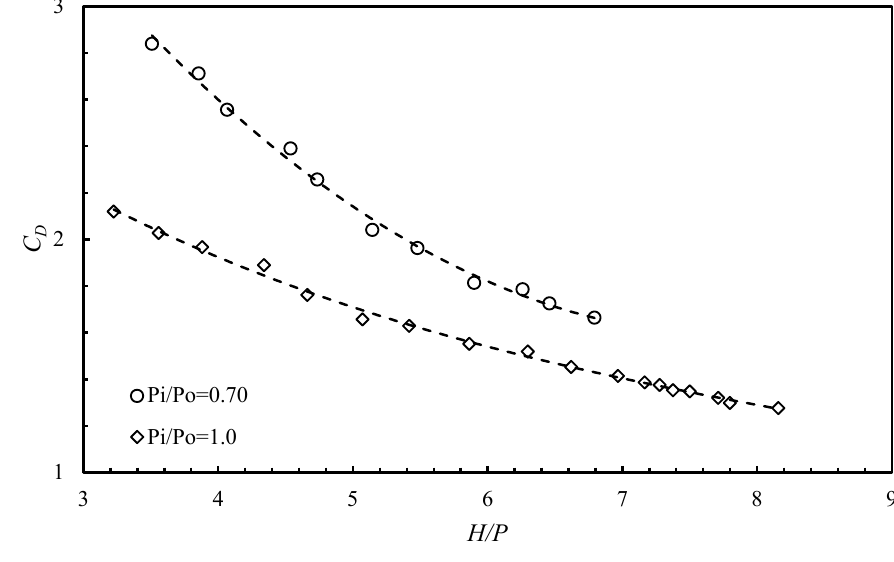
Figure 7. Variation of C D with H/P .